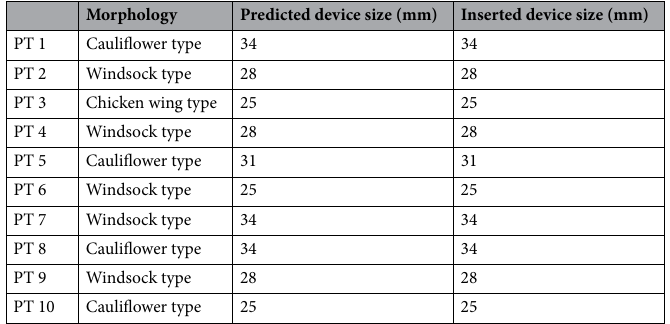
Table 3. Rehearsal simulation results of 10 patients. PT